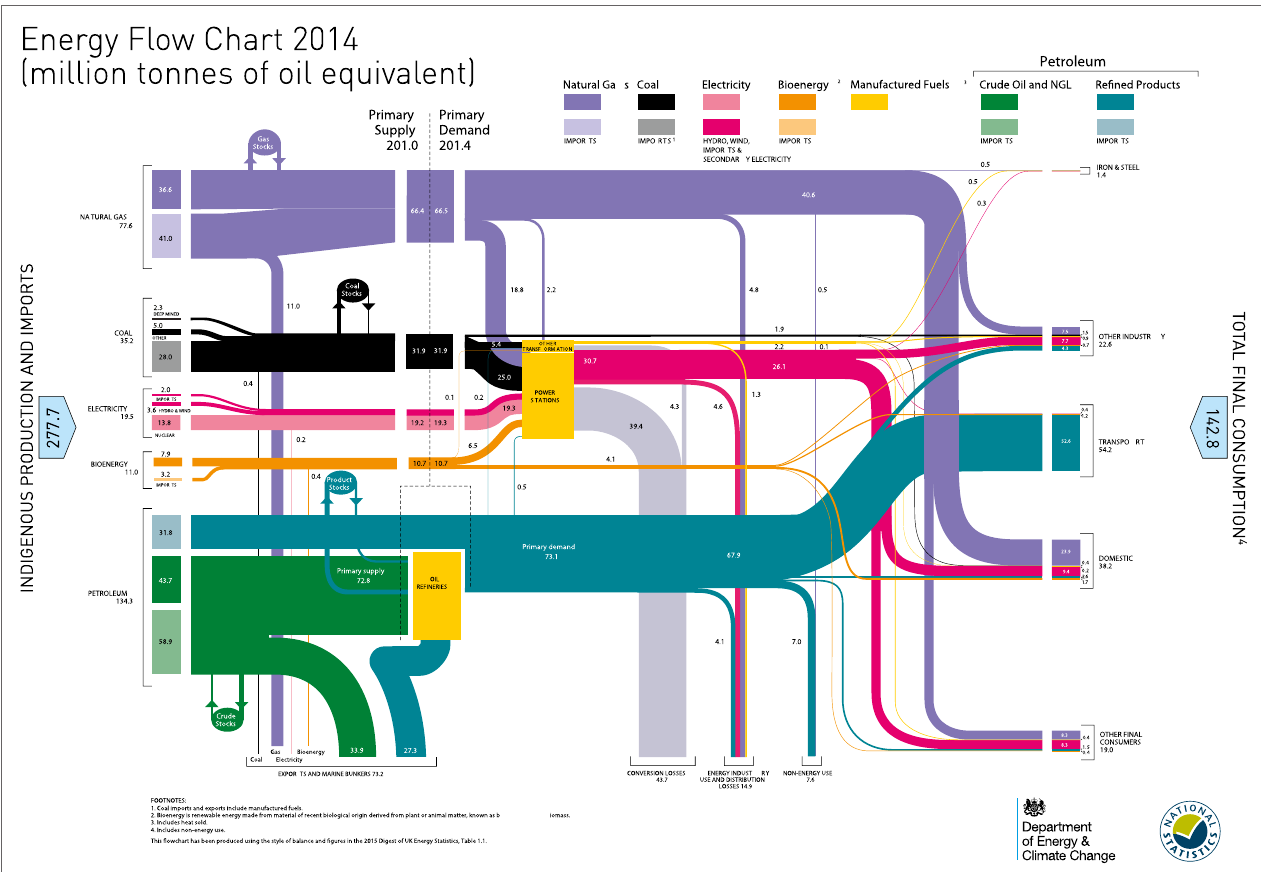
FiGUre 1 | sankey diagram for the United Kingdom for 2014 – values are shown aggregated over a year